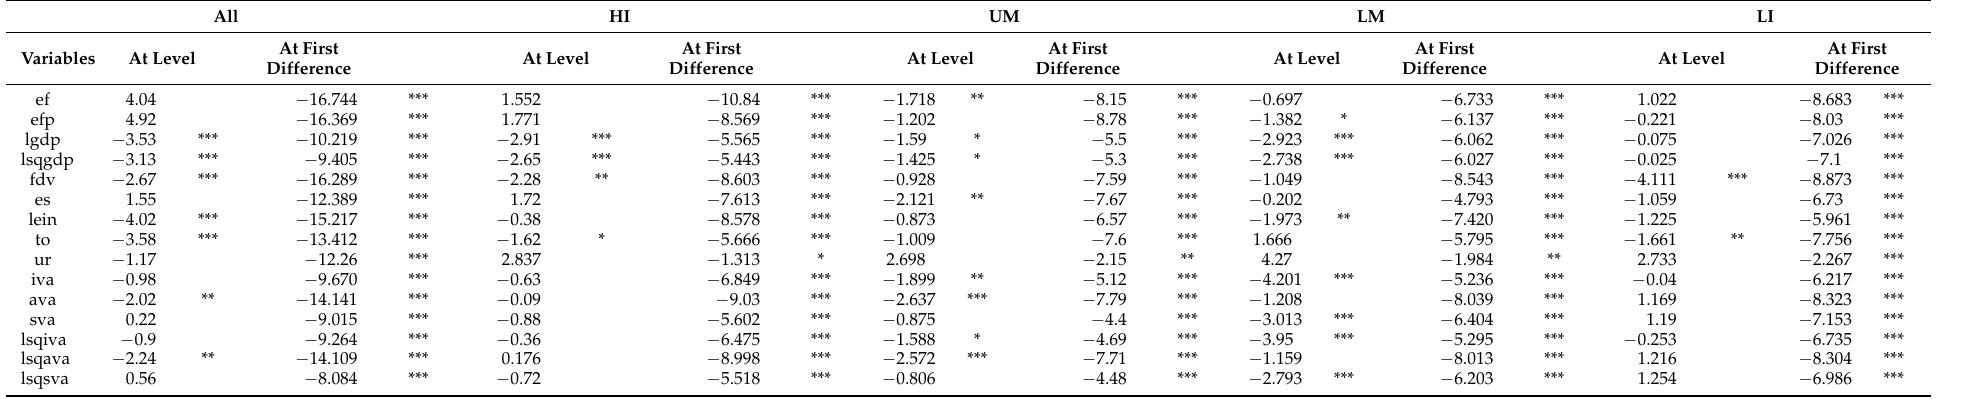
Table 4. Pesaran’s CADF